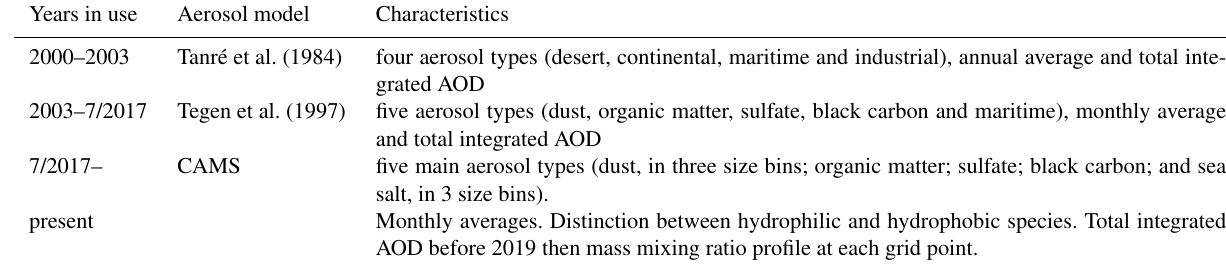
Table 1. Evolution in the treatment of radiative effect of aerosols in the ECMWF-IFS forecast model. Years in use Aerosol model Characteristics four aerosol types (desert, continental, maritime and industrial), annual average and total inte- grated AOD Tegen et al. (1997) five aerosol types (dust, organic matter, sulfate, black carbon and maritime), monthly average and total integrated AOD CAMS five main aerosol types (dust, in three size bins; organic matter; sulfate; black carbon; and